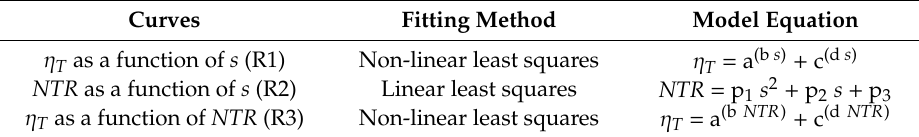
Table 4. Regression models and interpolation methods.